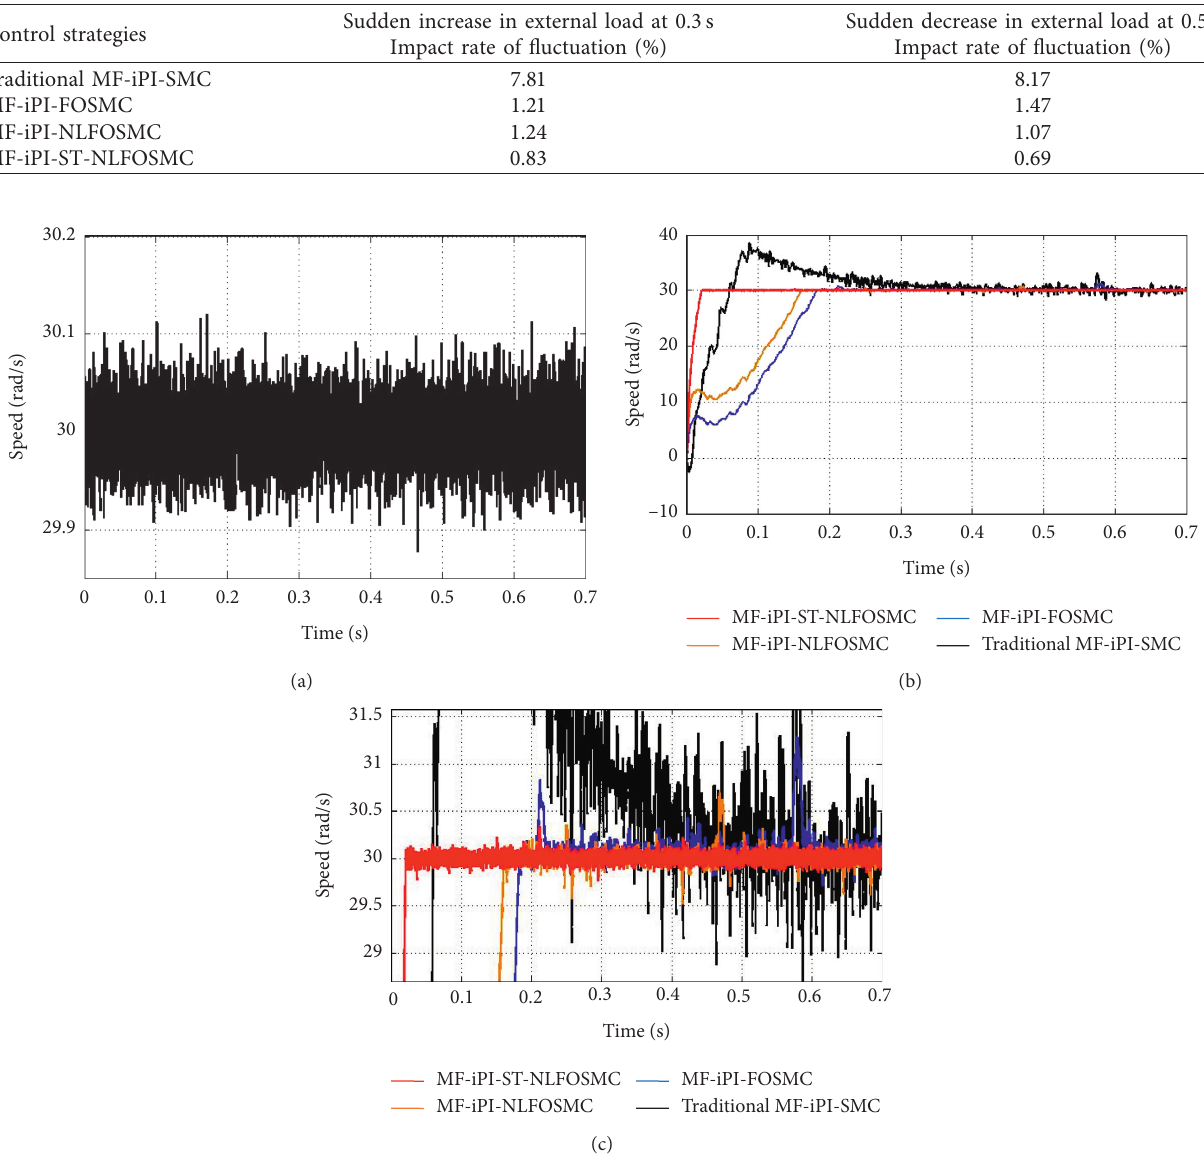
Figure 9: (a) Given speed with noise interference. (b) Speed response curves with the noise interference. (c) Partial enlarged views of